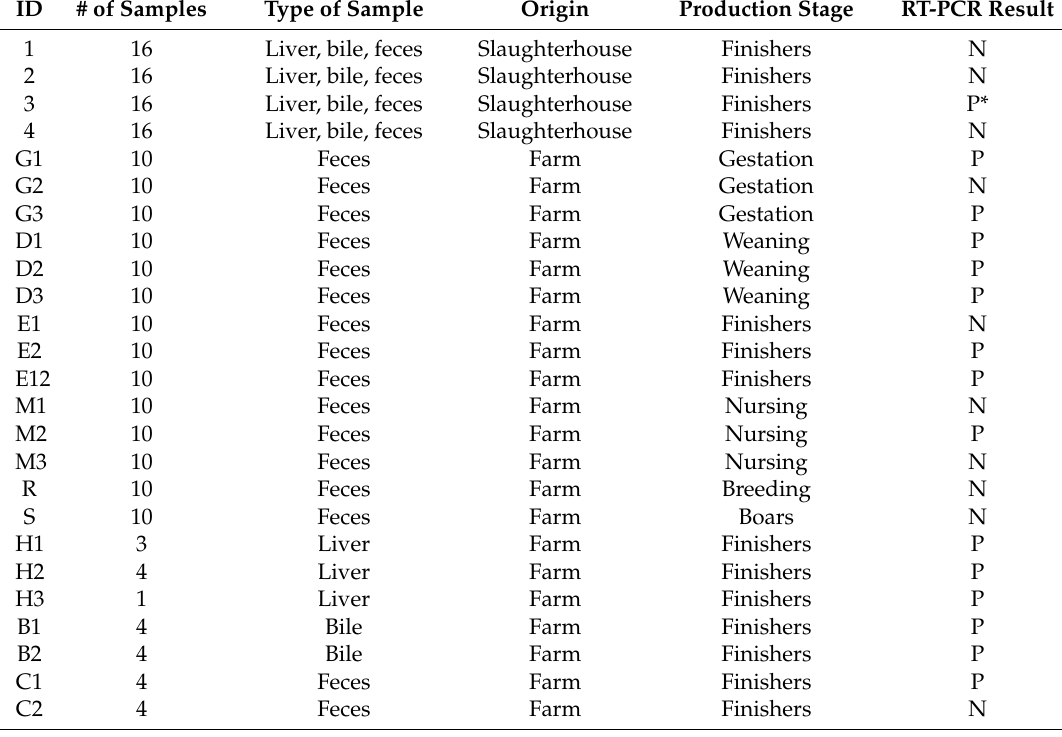
Table 1. Hepatitis E virus (HEV) PCR results of swine samples from different production